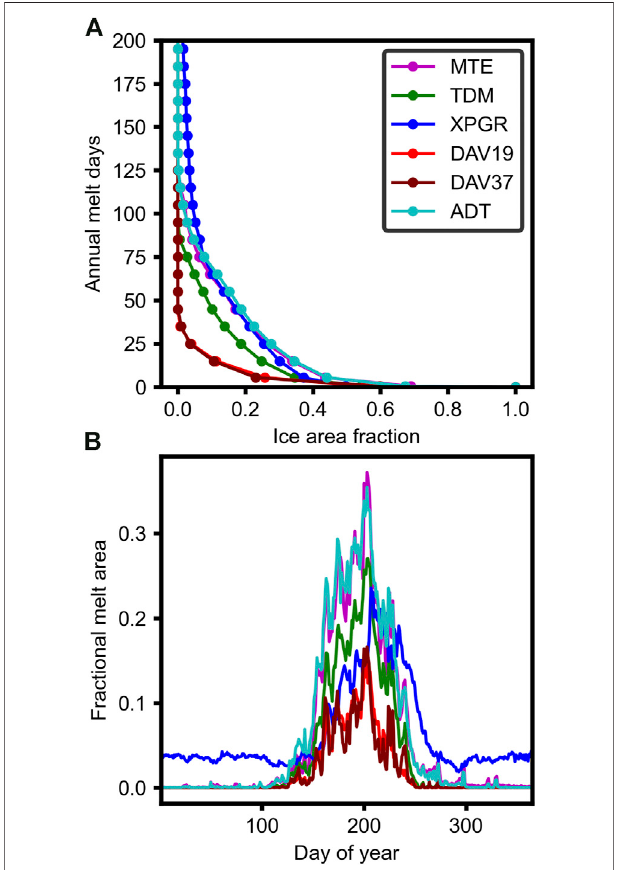
FIGURE 6 | Fractional area of the GrIS versus 2003 – 2007 average annual melt days for each of the six tested melt products (A) , and average fractional daily melt area versus time (B)